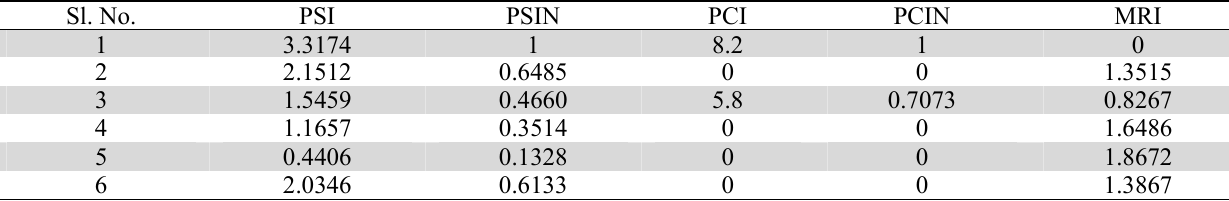
Material rating indices for example 3 Sl. No.